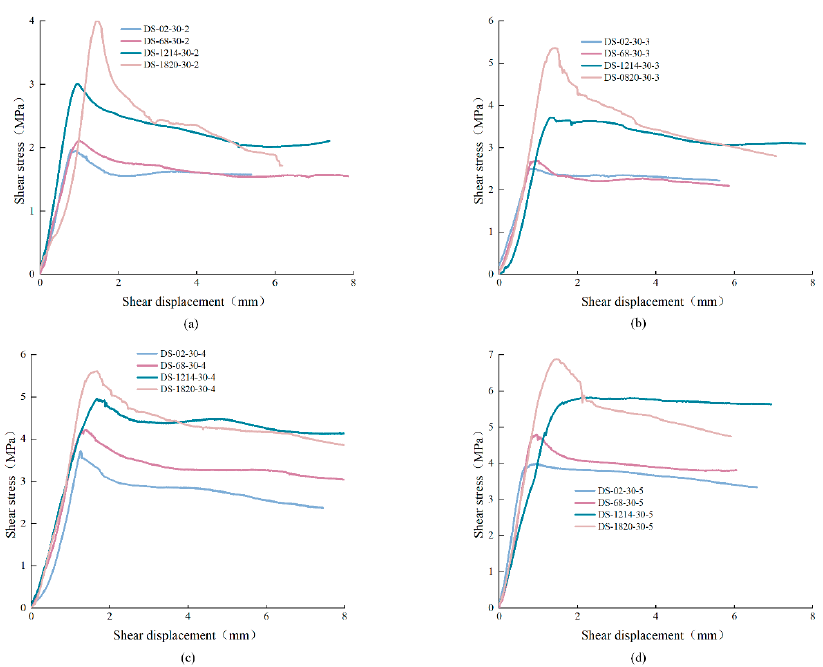
Figure 8. Shear stress-displacement curves of anchored structural planes under different normal stress: ( a ) σ = 2 MPa, ( b ) σ = 3 MPa, ( c ) σ = 4 MPa, ( d ) σ = 5 Mpa (specimen ID: DS-ab- α - σ , where DS represents direct shear experiment, ab represents the range of JRC, α means the anchorage angle, and σ means the normal stress).